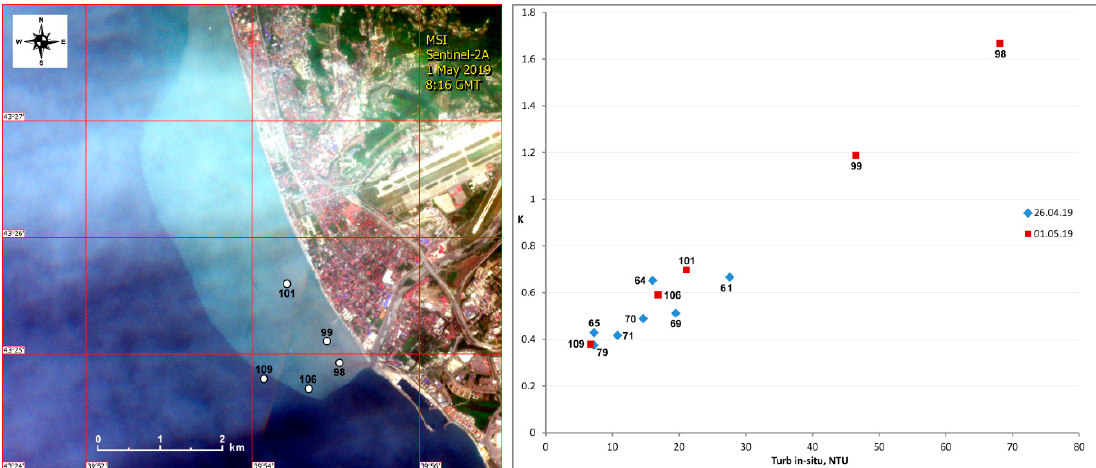
Figure 14. Left: fragment of a Sentinel-2A MSI satellite image of May 1. Marks indicate locations where samples were taken for X-ray phase analysis. Right: graph shows the ratio of the percentage of quartz in the dry matter of the suspension to the percentage of clay minerals (K) depending on turbidity (Turb in situ, NTU). The station numbers are indicated beside the marks. Positions of the stations on 26 April (blue marks) are shown in Figure 10a.